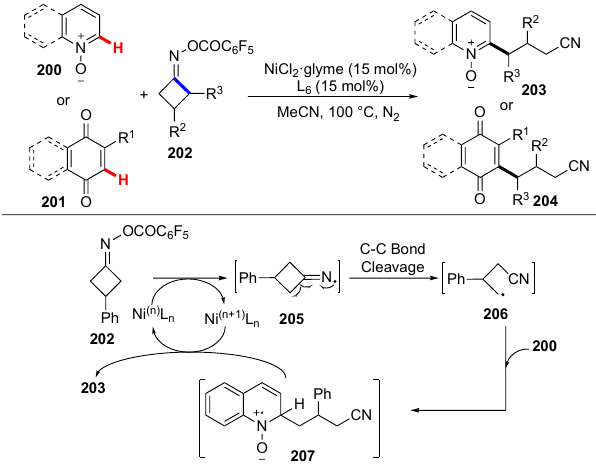
Scheme 24. Ir-photocatalyzed synthesis of naphthalenones. The term Ir(ppy) 3 * refers to the excited state of the